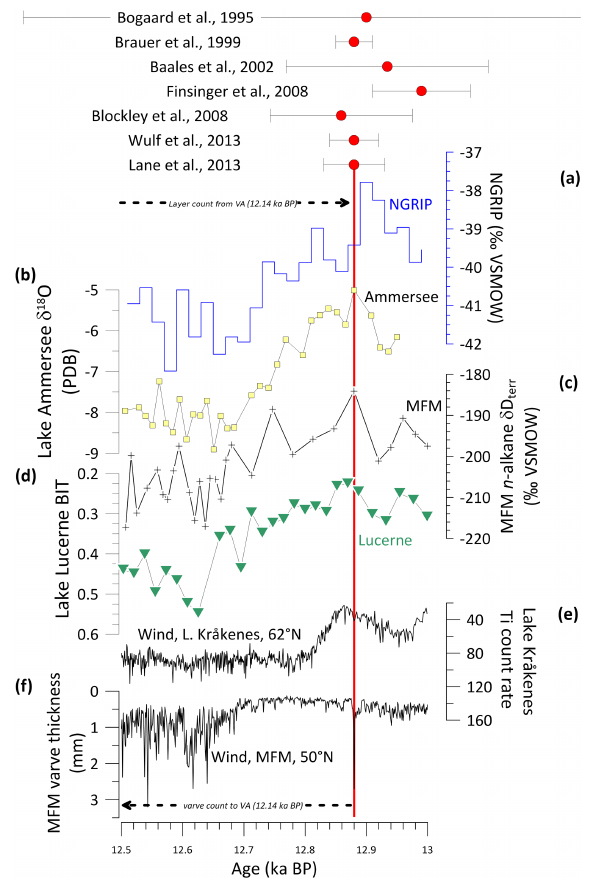
abrupt cooling predates this by ∼ 24 years) (Fig. 4). In